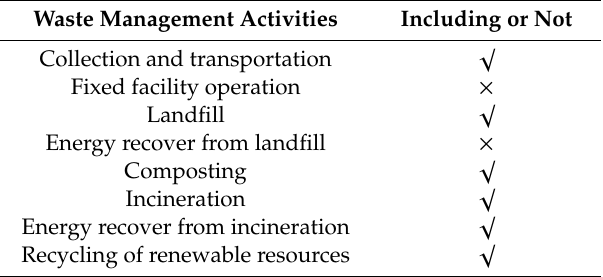
Table 2. GHG emissions evaluation scope in the